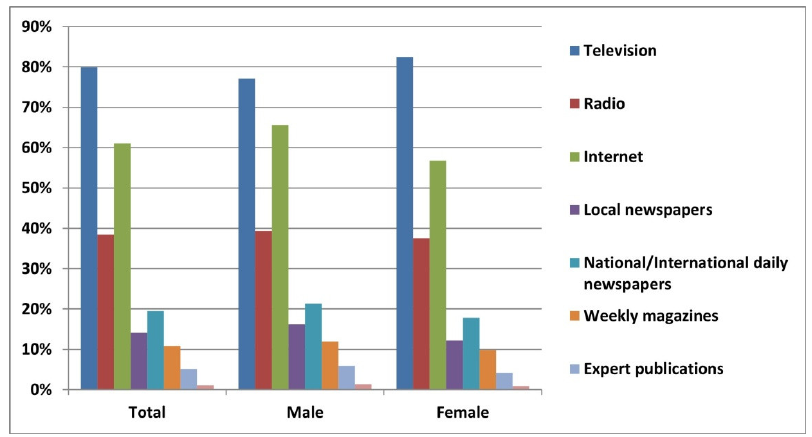
Figure 10. Main sources of general information.